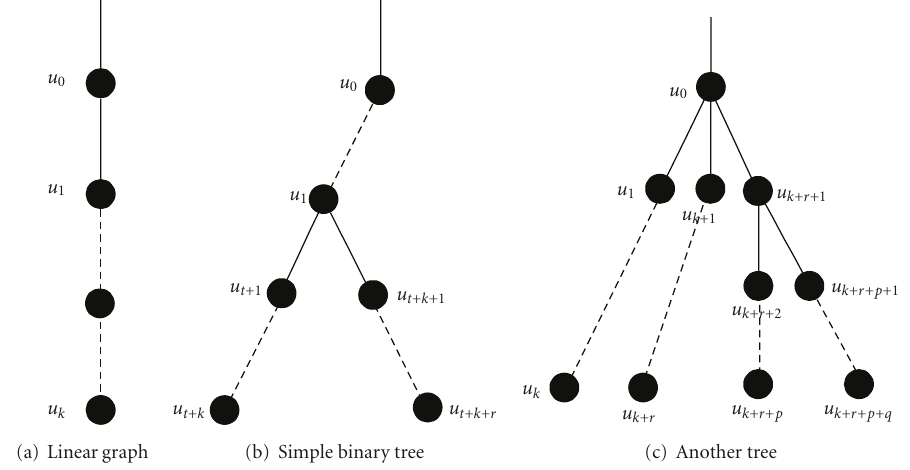
Figure 3: An illustration of time-optimal packet scheduling [17].